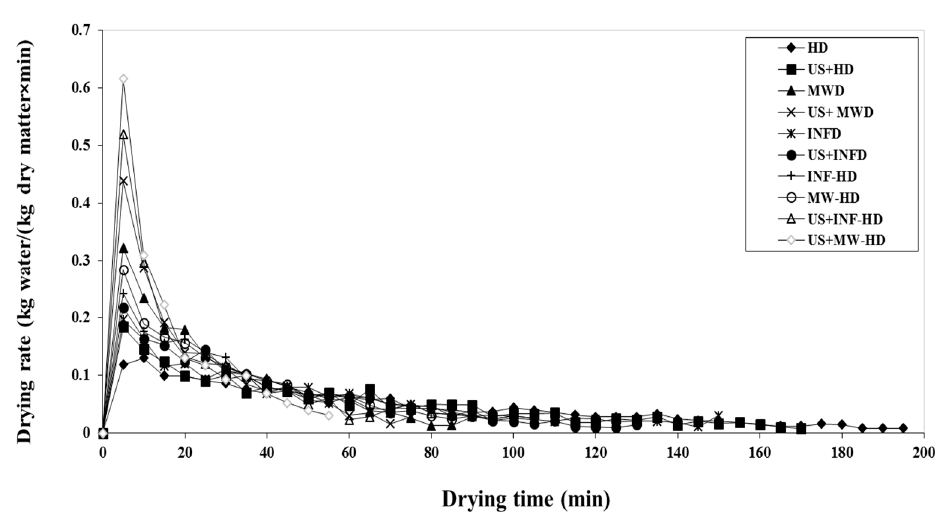
Figure 2. Drying rate of the carrot samples pretreated with ultrasound during different drying methods.